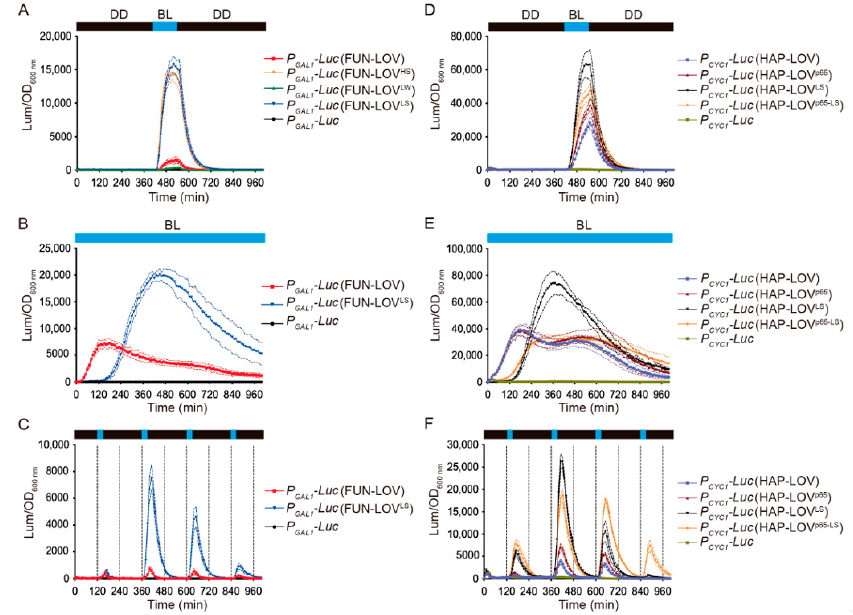
Figure 5. Molecular optimization of the promoter strength and plasmid copy number for the FUN-LOV and HAP-LOV optogenetic systems. ( A ) Yeast strains containing the FUN-LOV switch, or its variants, were subjected to a blue-light (BL) pulse of 120 min (dashed lines), and two of them (FUN-LOV and FUN-LOV LS ) were subjected to constant BL illumination ( B ) or BL pulses of 30 min every 4 h ( C ). ( D ) Yeast strains carrying the HAP-LOV switch, or its variants, were subjected to a BL pulse of 120 min (dashed lines), constant BL illumination ( E ), or BL pulses of 30 min every 4 h ( F ). In all panels, yeast strains carrying the GAL1 ( P GAL1 ) or CYC1 ( P CYC1 ) promoters controlling luciferase ( Luc ) expression, but lacking the corresponding switches, were used as controls. The graphs show the average of normalized luciferase expression in six biological replicates, with standard deviation represented as regions between dashed lines. Abbreviations: H, high copy plasmid; L, low copy plasmid; S, strong promoter; W, weak promoter.